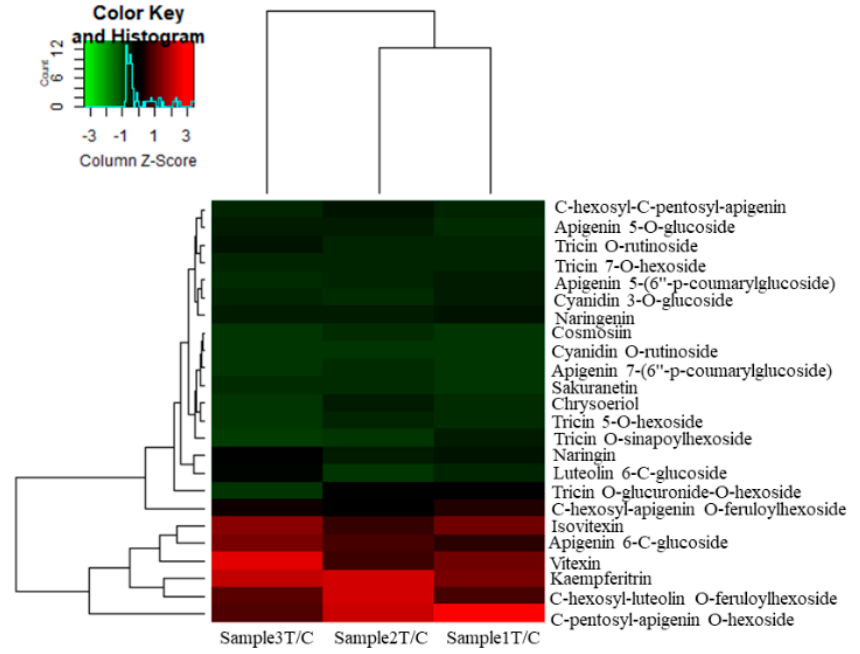
Figure 5. Modulation of phenylpropanoid and flavonoid biosynthesis pathways in date palm leaves under UV ‐ B irradia ‐ tion. Detected metabolites are indicated with red color.